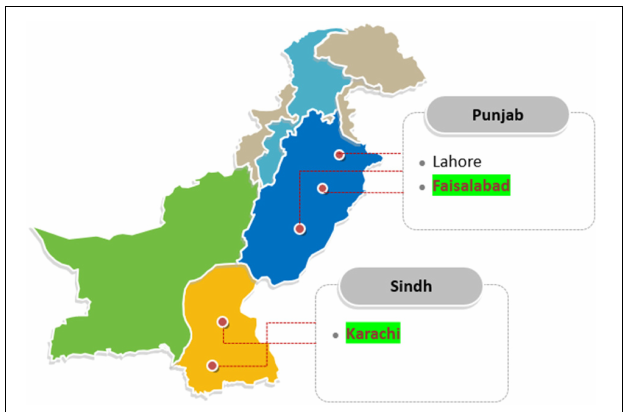
FIGURE 1 | Location of freshwater and marine fish collection from different areas of Pakistan. Four locations were selected from the Faisalabad for freshwater species collection: Novelty pull fish markets, Metro mall, Kataria fish hatchery, and Satin fish farms, in Punjab, Pakistan. Marine fish species were collected from the Arabian Sea of Karachi, Sindh,